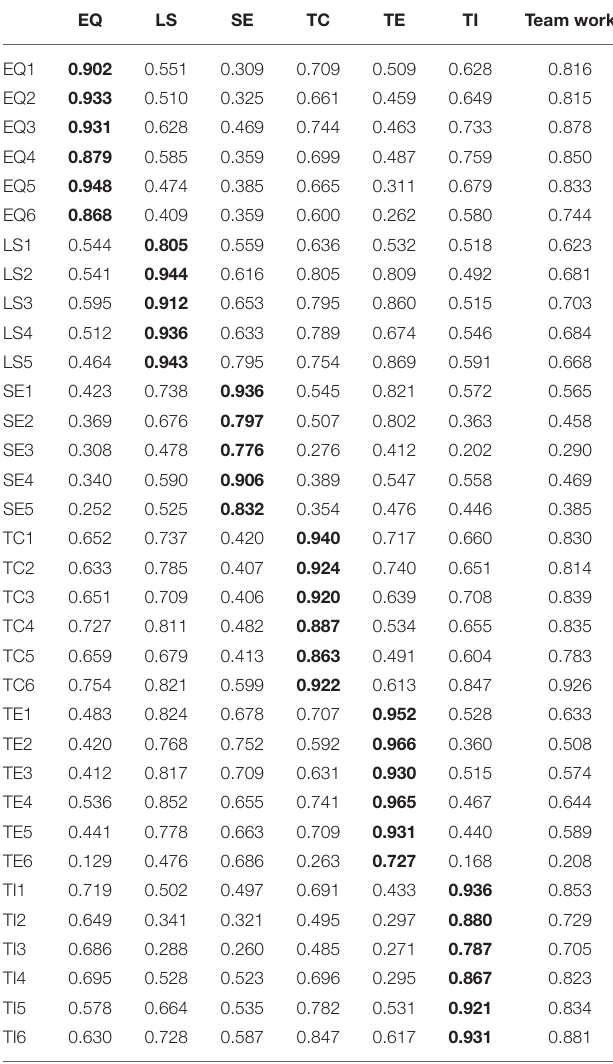
TABLE 5 | Standardized factor loadings and cross loadings of the outer model.